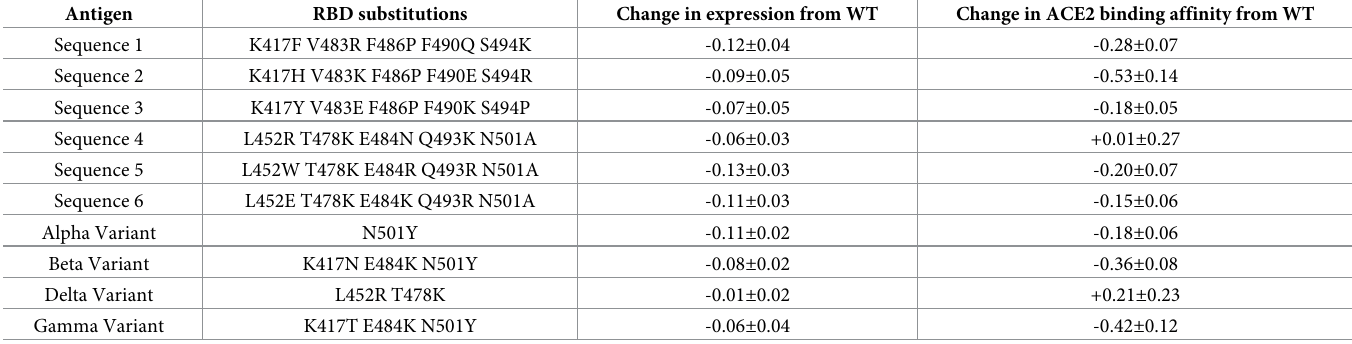
Table 1. RBD substitutions, changes in expression, and changes in ACE2 binding affinity (calculated using the neural networks) for designed antigens and circulat- ing variants. Antigen RBD substitutions Change in expression from